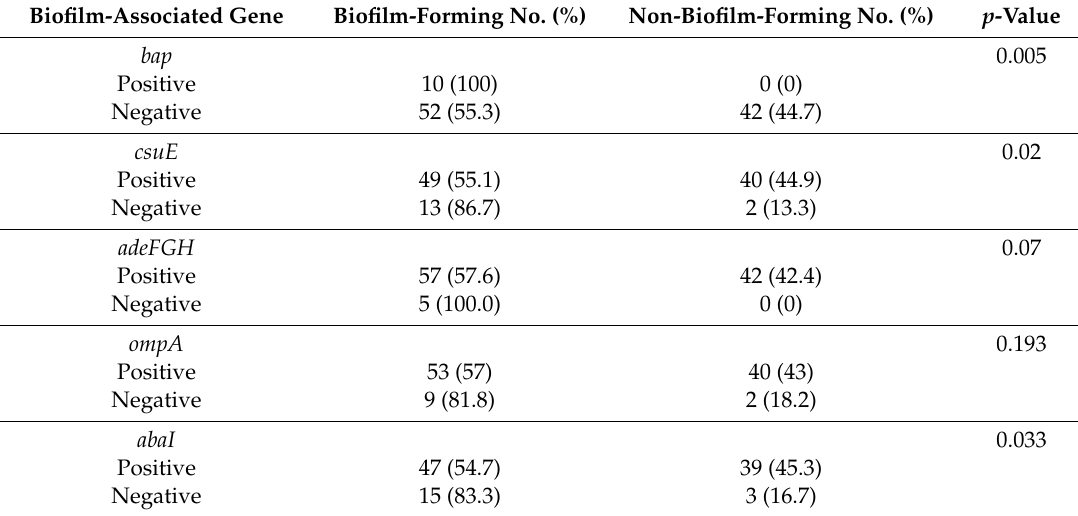
Table 4. Relationship between the presence of biofilm-associated genes and biofilm-forming capacities among the A. baumannii